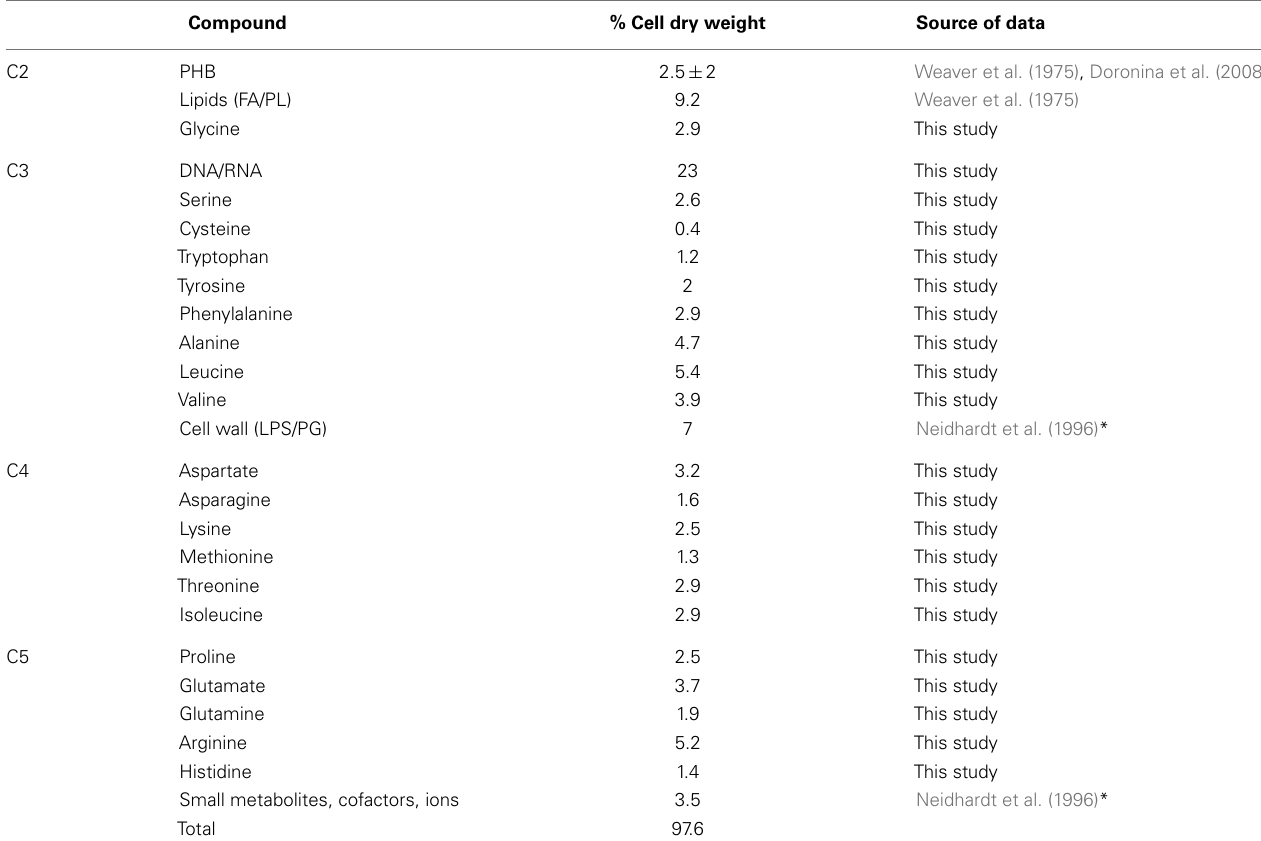
TableA1 | Macromolecule and amino acid composition of cells grown on